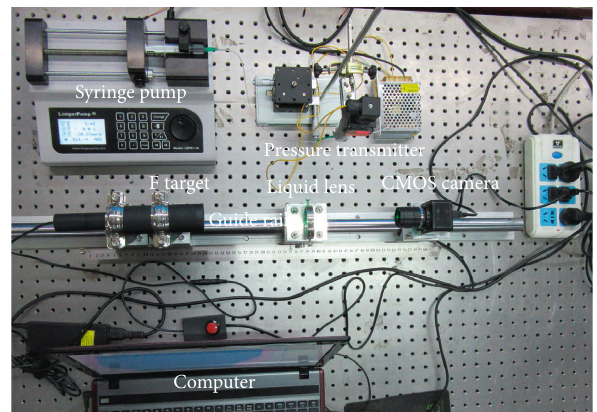
Figure 7: A photograph of the experimental setup to measure focusing performance of the fabricated lens.